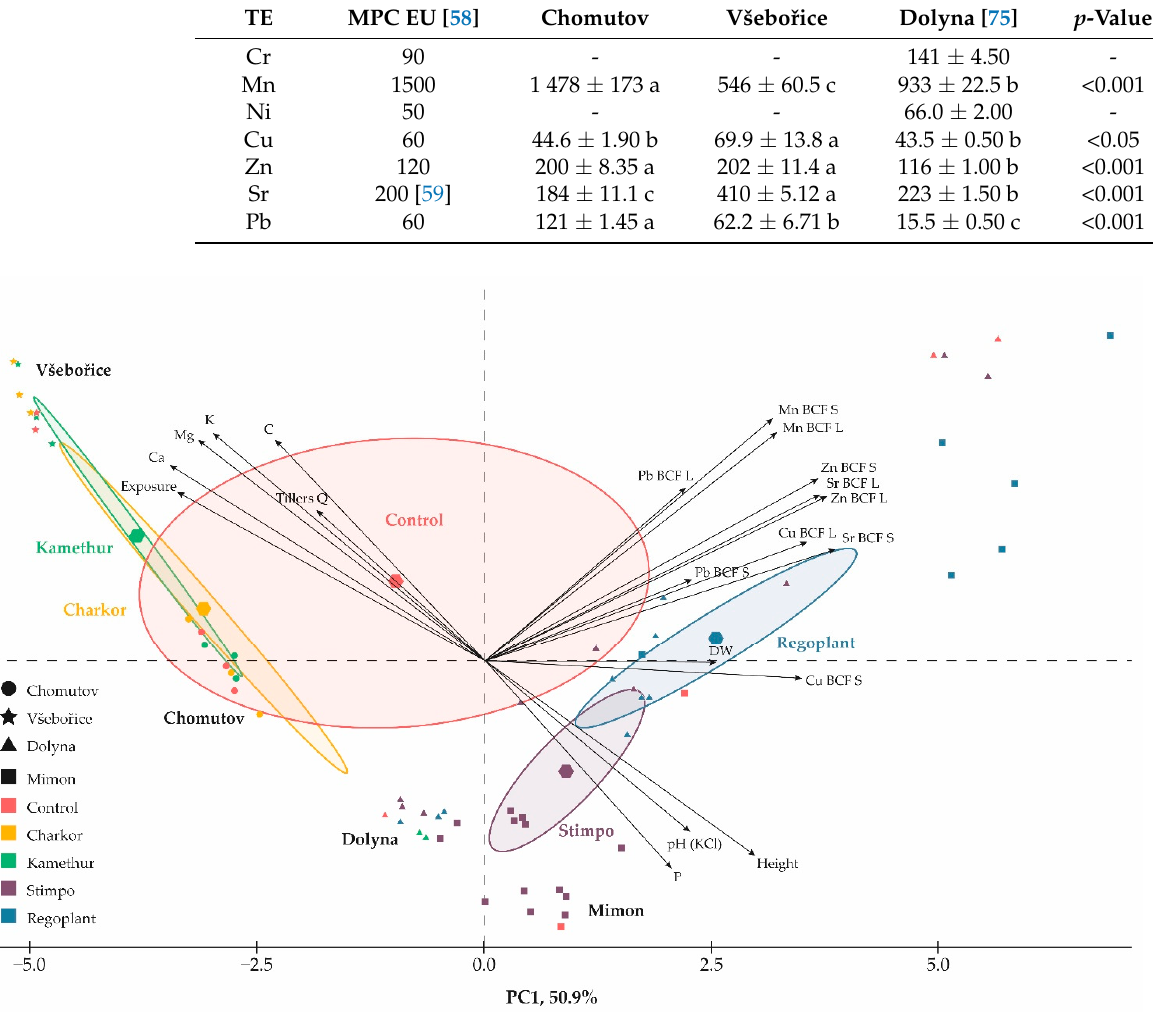
Table 3. TE concentrations (mg kg − 1 ) in soils. Different letters indicate a significant difference between the values within one TE ( p < 0.05).